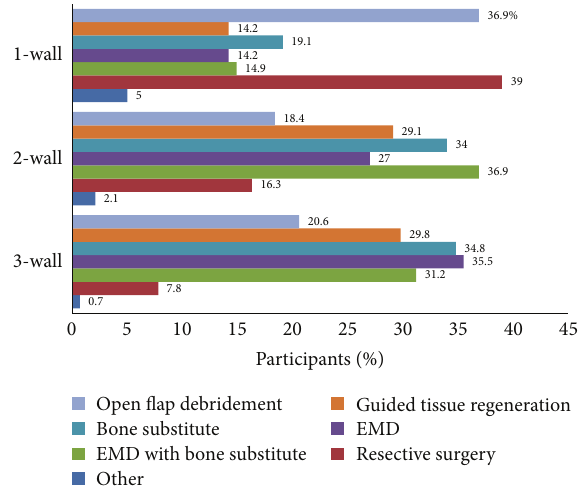
Figure 3: Participants’ responses: frequencies of options for the treatment of three-, two-, and one-wall intrabony defects.